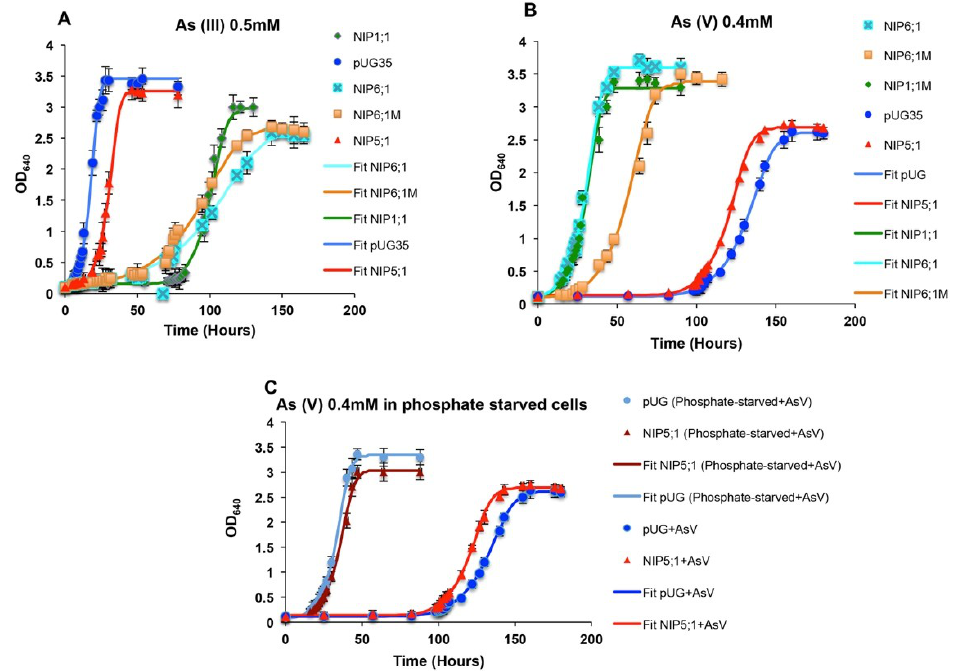
Figure 8. Growth assays of S. cerevisiae strains in arsenium. Yeast cells expressing empty plasmid pUG35 or grapevine NIPs were washed and inoculated (A 260 = 0.1) in the minimal media containing ( A ) 0.5 mM arsenite (As III) and ( B ) 0.4 mM arsenate (As V). ( C ) In another set of experiments, yeast strains (control and Vv TnNIP5;1), which did not show involvement in As (III) flux and hence were sensitive to As (V), were grown in low-phosphate media. Thereafter, the phosphate-starved cells were subjected to grow in the presence of As (V), under phosphate-replete condition, showing abolished arsenate toxicity in these strains. Obtained data points of the curve were fitted to the ComBase tool DMFit (online) [30] and growth parameters like specific growth rate (h − 1 ) and final biomass of the fits were estimated (Table S2). Data is represented in the mean ± SD of at least two independent experiments with three replicates.